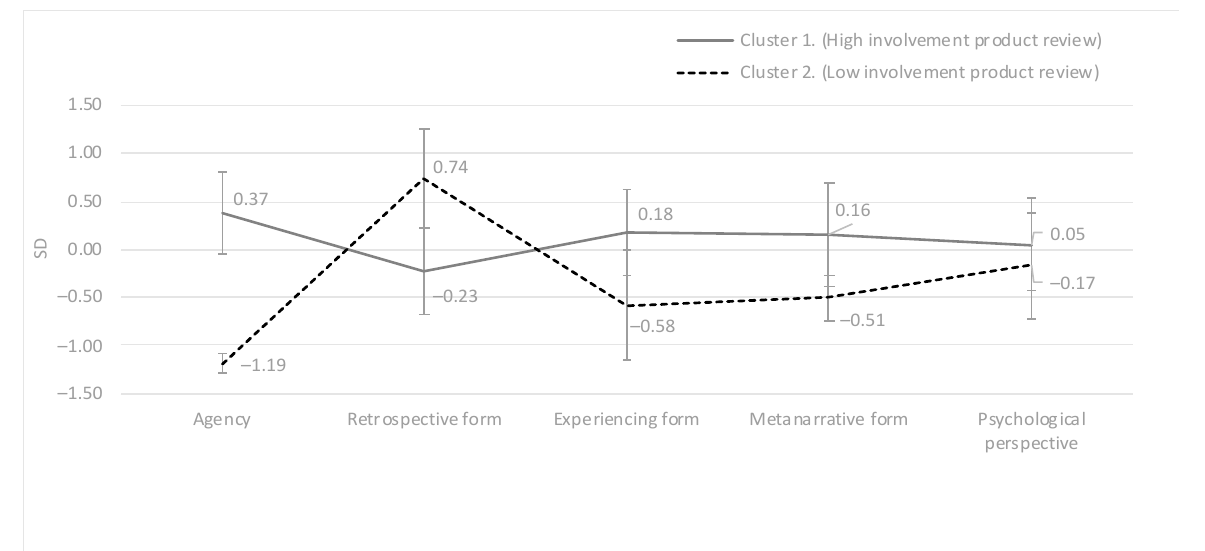
Figure 1. Profiles of the two clusters of product reviews based on the relative frequencies of narrative compositional categories (standardized data).